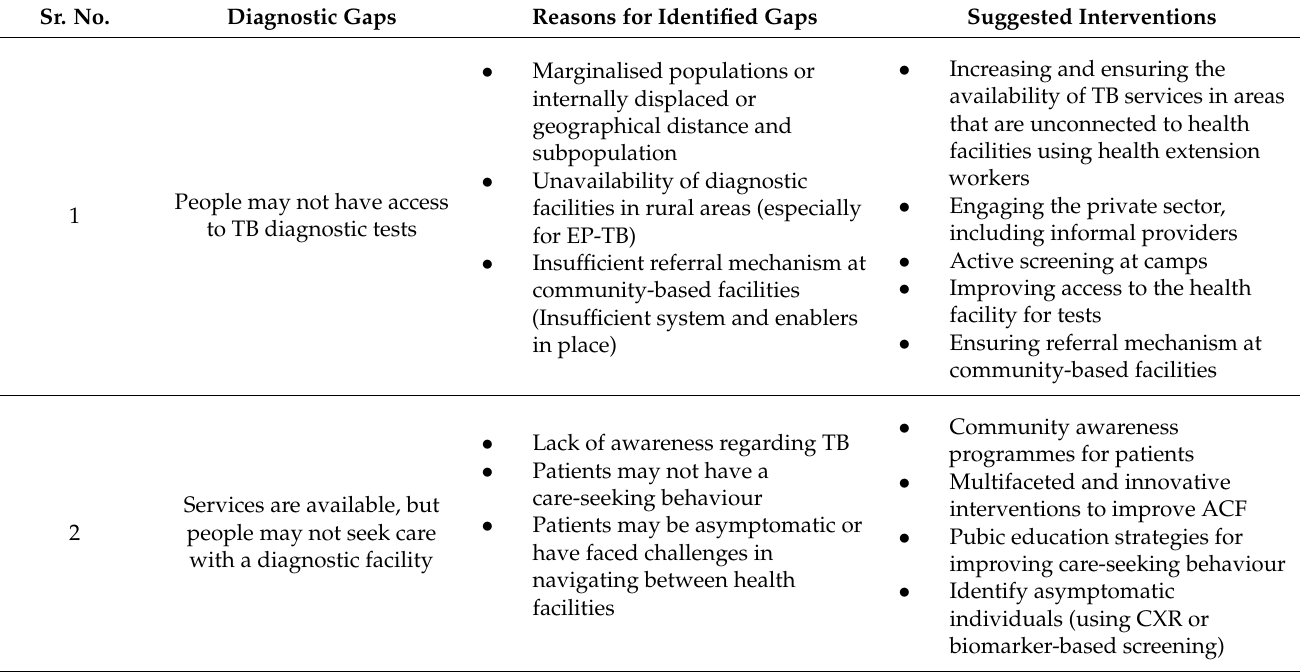
Table 1. Identified diagnostic gaps and possible intervention matrix through qualitative